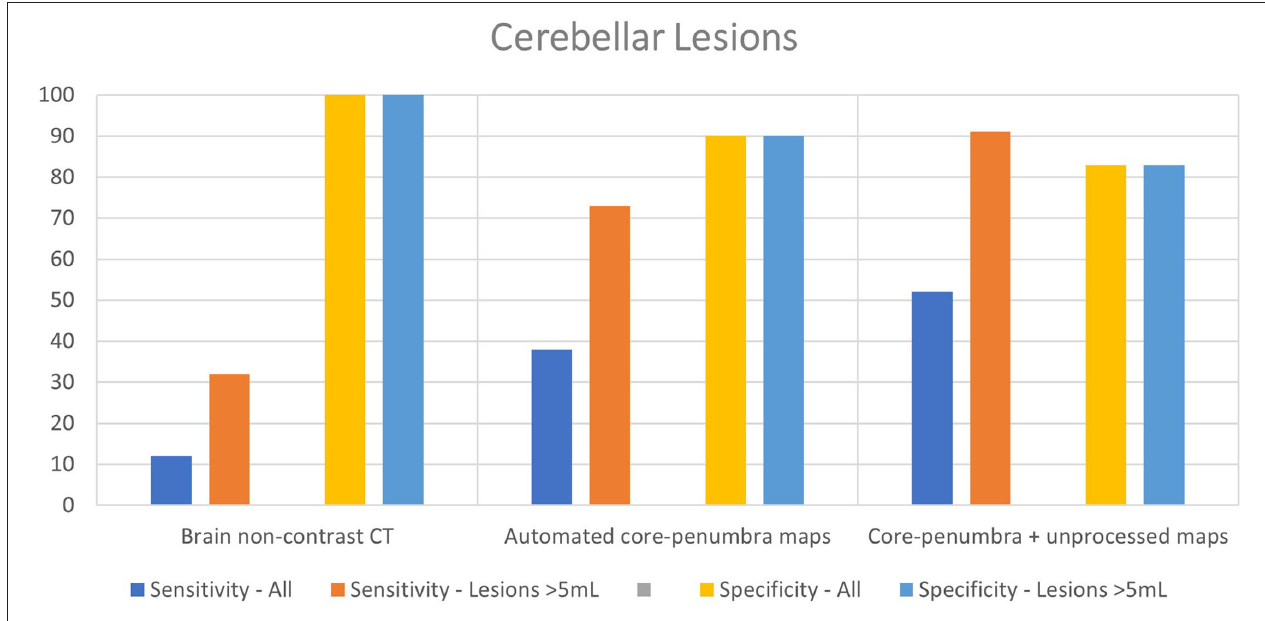
FIGURE 2 | Sensitivity and specificity of different imaging modalities for cerebellar lesions overall and cerebellar lesions > 5mL.